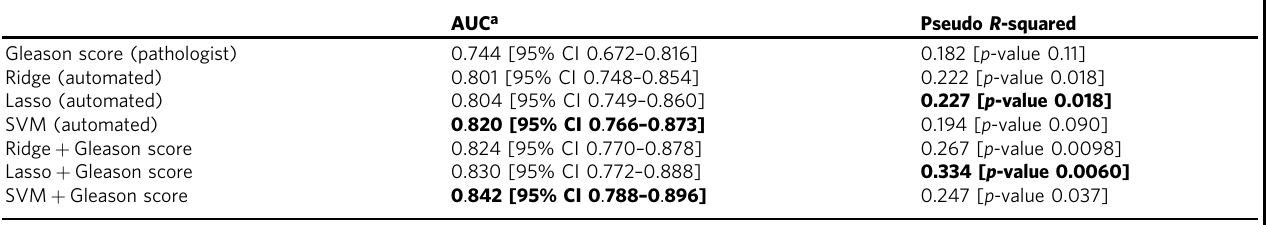
Table 2 Comparison of biochemical recurrence (BCR) within 1 year.